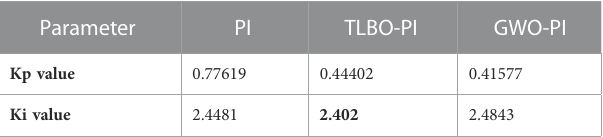
TABLE 1 Kp and Ki values.